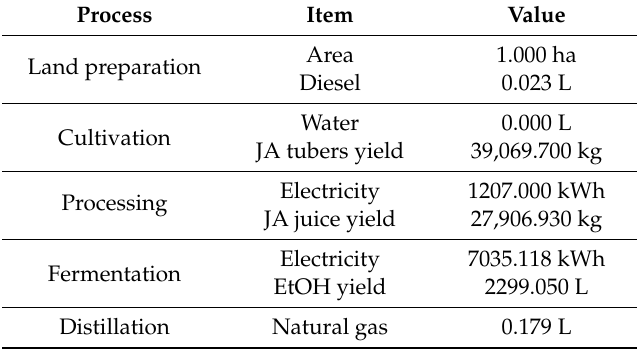
Table 4. Inventory for the considered processes of bioethanol production from Jerusalem